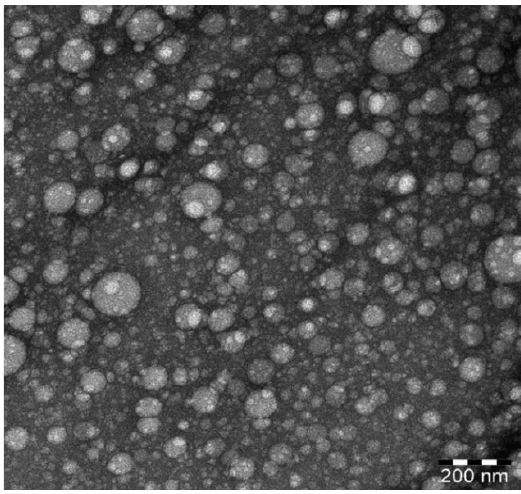
Figure 7. TEM image of the optimized formulation.